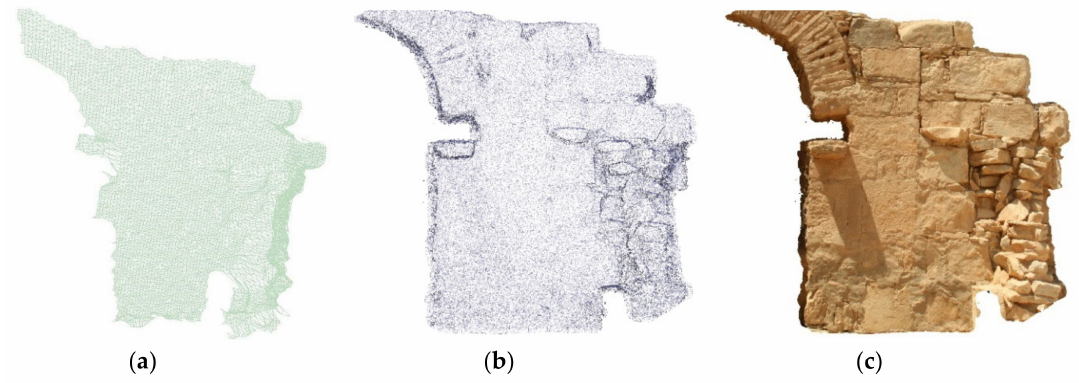
Figure 15. Experimental area from Qusayr ‘Amra that su ff ering degradation: ( a ) 3D wireframe using TLS;( b )3Dwireframeusingimage–basedmodeling; ( c